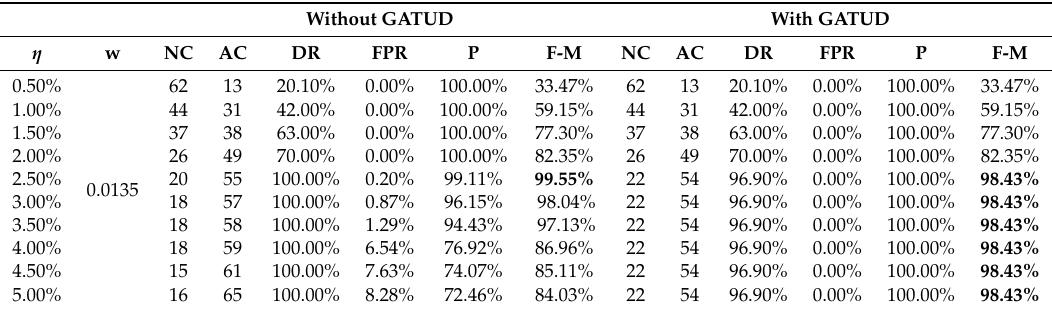
Table 16. The acceptable thresholds η that produce better accuracy results of the separation of abnormal observations on each dataset when GATUD was integrated Data Sets η DUWWTP SimData1 SimData2